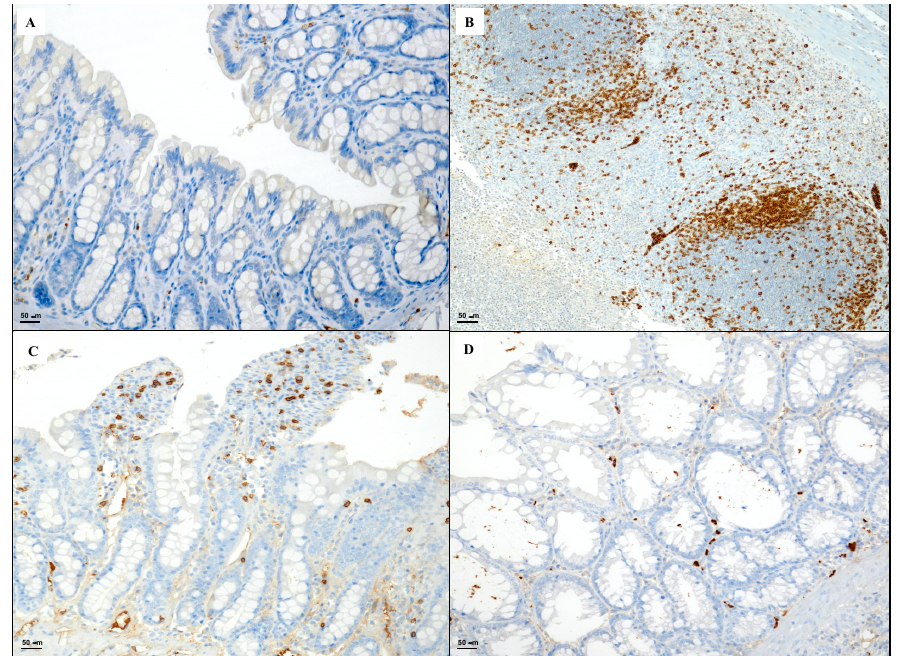
Figure 5. Representative CD20 immunostaining (original magnification ×20) of tissues derived from control ( A ), DNBS + Drug vehicle ( B ), DNBS + Poly ( C ), and DNBS + Poly + HA ( D ).